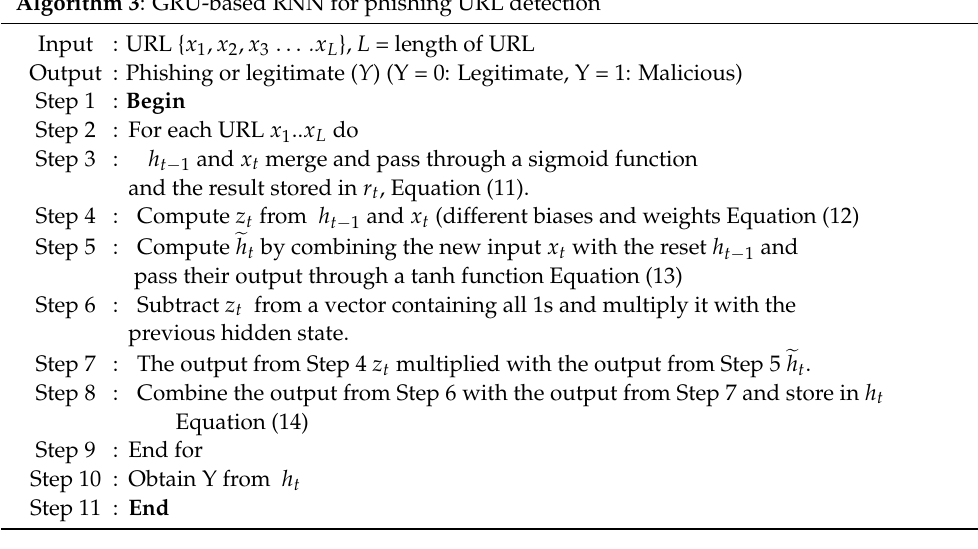
Algorithm 3 : GRU-based RNN for phishing URL detection